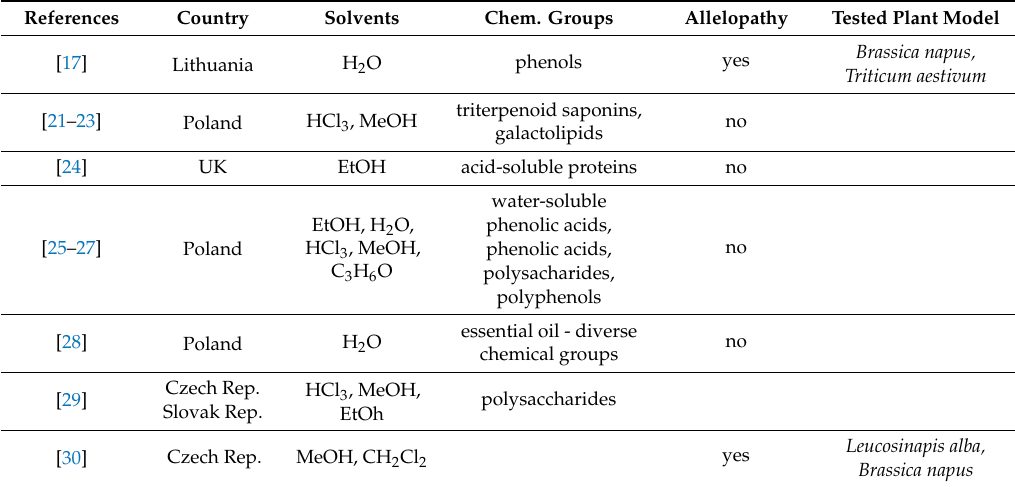
Table 1. Overview table with the up-to-date publications focusing on chemical composition of Impatiens parviflora